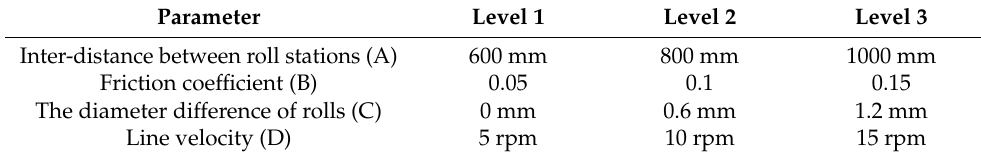
Table 5. Parameters and their respective levels.